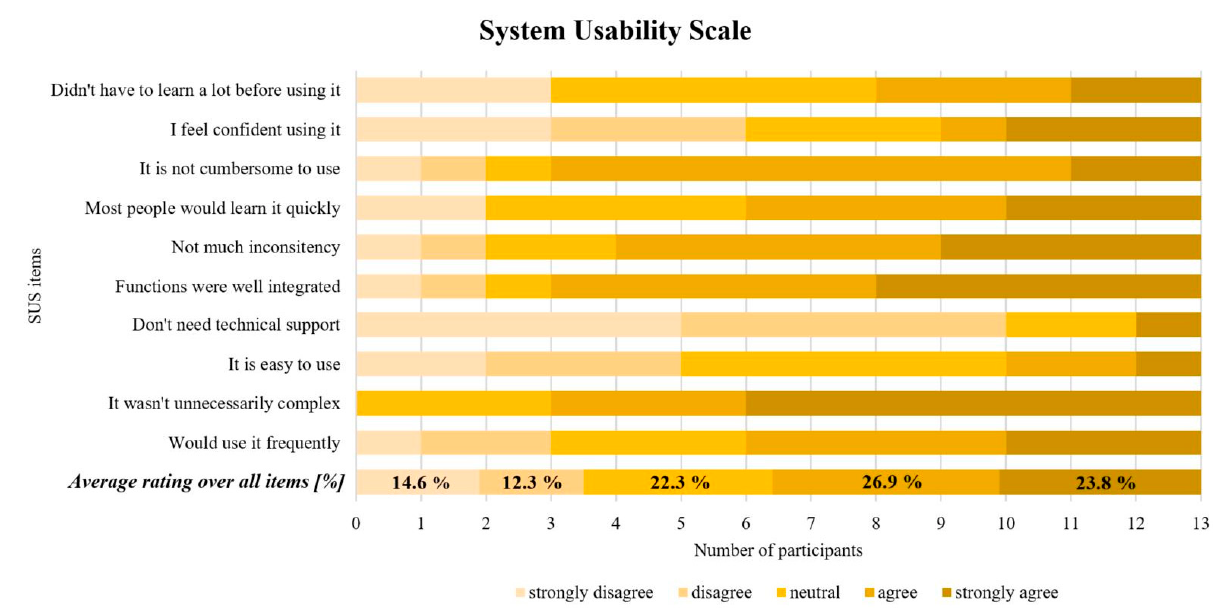
Figure 3. Summary diagram of the System Usability Scale. Ten SUS items and the average rating over all items including percentages.